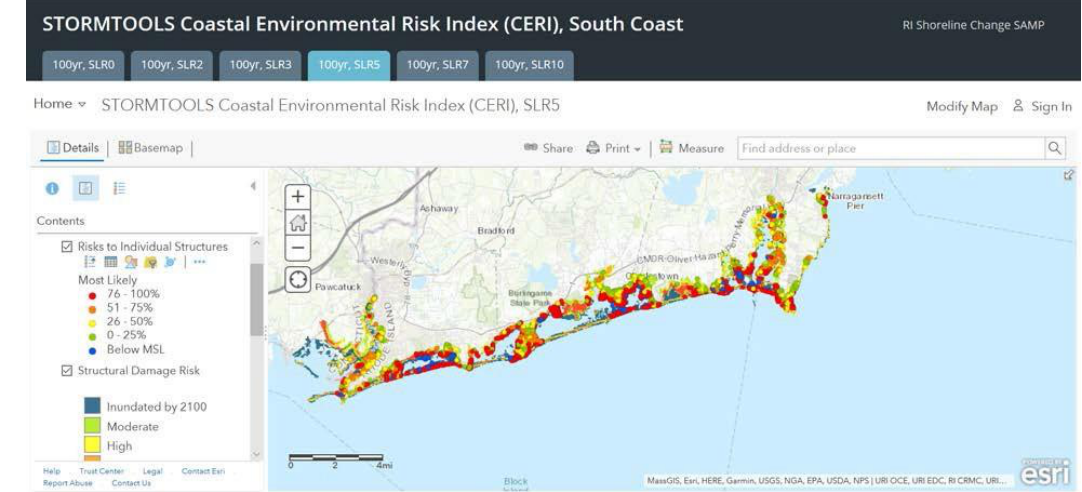
Figure 13. CERI predicted damage and risk maps for 100 yr surge with 5 ft of SLR.